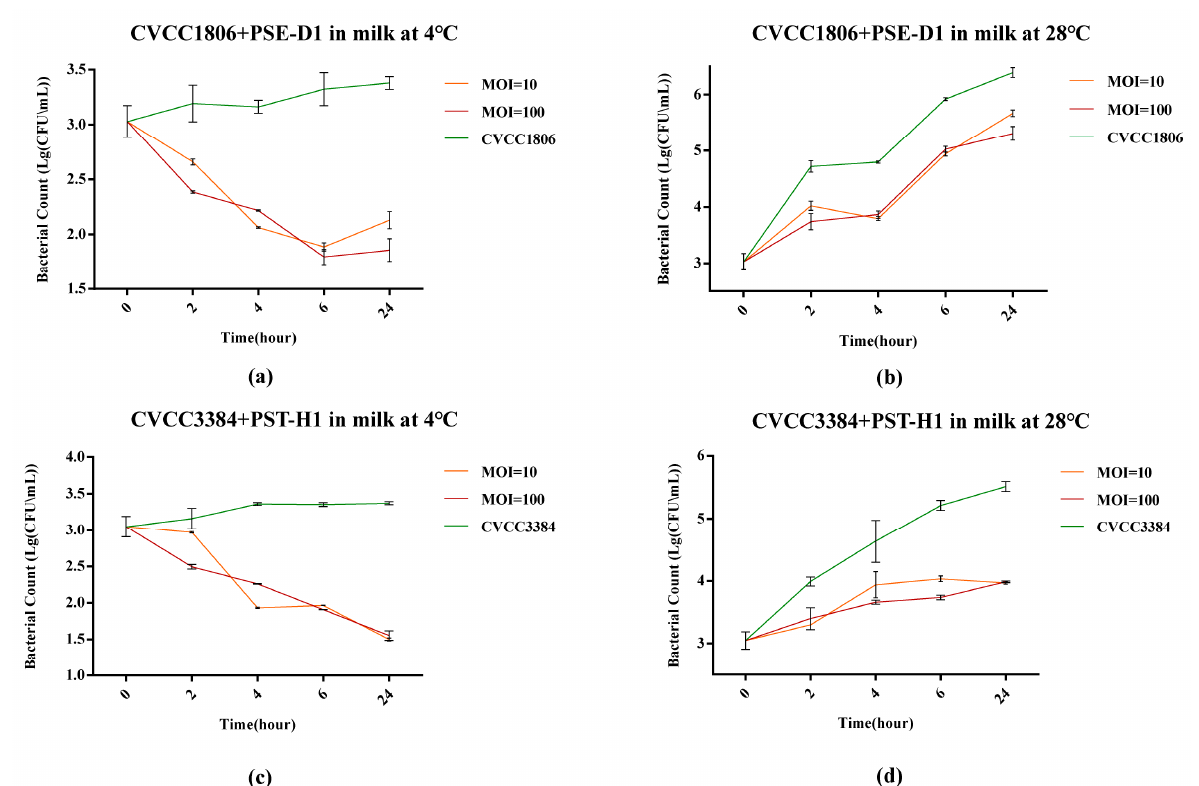
Figure 10. Determination of the antibacterial effect of phages in milk at different temperatures. ( a ) CVCC1806+PSE-D1 in milk at 4 °C. ( b ) CVCC1806+PSE-D1 in milk at 28 °C. ( c ) CVCC3384+PST-H1 in milk at 4 °C. ( d ) CVCC3384+PST-H1 in milk at 28 °C.